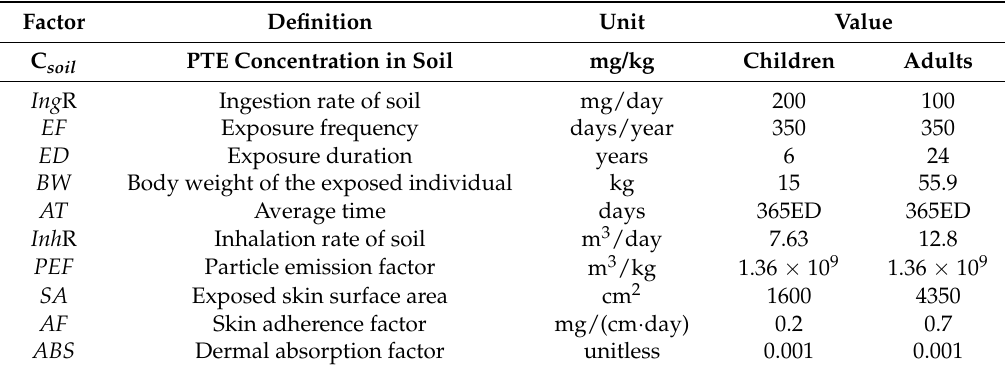
Table 1. Reference values of parameters for health risk assessment (HRA) of potential toxic elements (PTEs) pollution